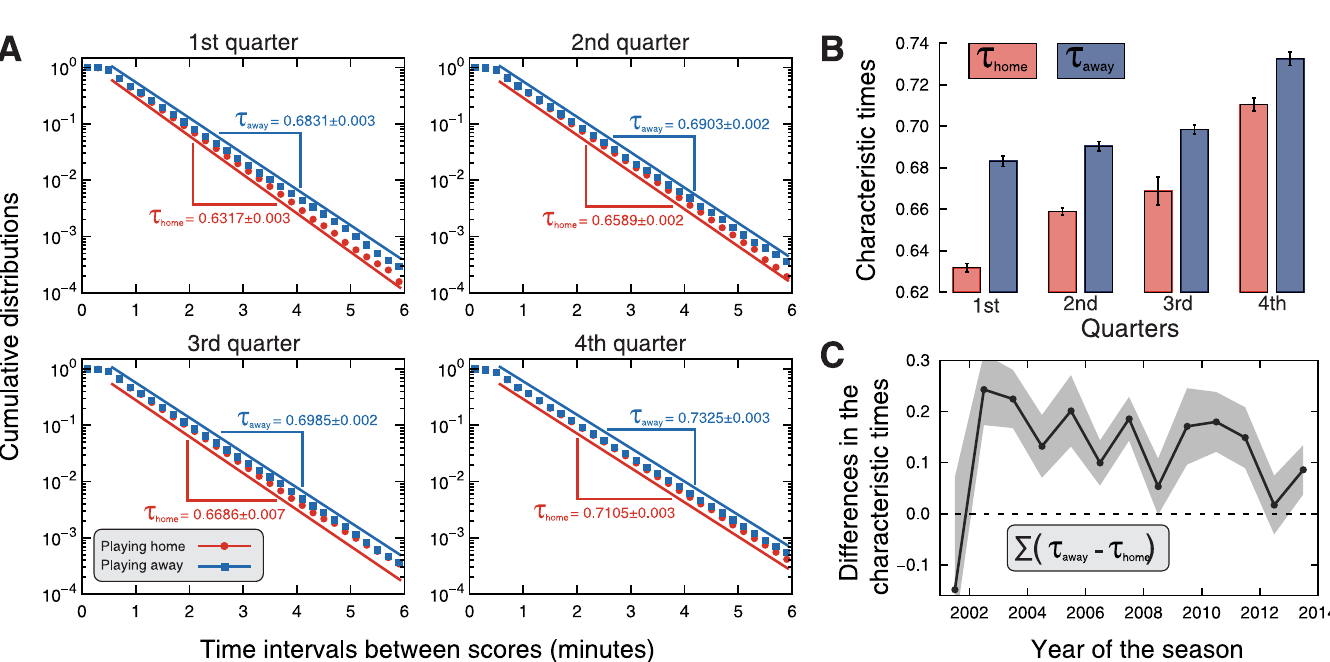
Fig 5. Evidence for home advantage in the time intervals between scores. (A) Cumulative distributions of the time intervals between stores when the teams play home (red dots) and away (blue squares). The panels show the distributions for the four quarters (period of 12 minutes in which the games are played). Here we have aggregated data from all seasons (see S3, S4, S5 and S6 Figs for individual results). All distributions are well approximated by exponential distributions, that is, P ( Δ t ) * e − Δ t / τ , where τ = τ home is the characteristic time interval when playing home and τ = τ away is the analogous when playing away. Notice that the plots are in log-lin scale and thus the exponential decay is linearized. The values of τ home and τ away were estimated via maximum likelihood method and are shown in the plots. The straight lines are guides for the eyes indicating the adjusted behavior of P ( Δ t ). We observe that these distributions decay faster for teams playing home than playing away. (B) Bar plots of the characteristic times τ home and τ away for each quarter. The error bars stand for 95% bootstrap confidence intervals. The characteristic times are systematically smaller when the teams play home than when playing way; we further observe that the difference τ away − τ home decreases with the passing of the quarters. (C) Evolution of the sum of the differences between the characteristic times at home and away [ ∑ ( τ away − τ home ), over all quarters] along the NBA seasons. The shaded areas stand for 95% bootstrap confidence